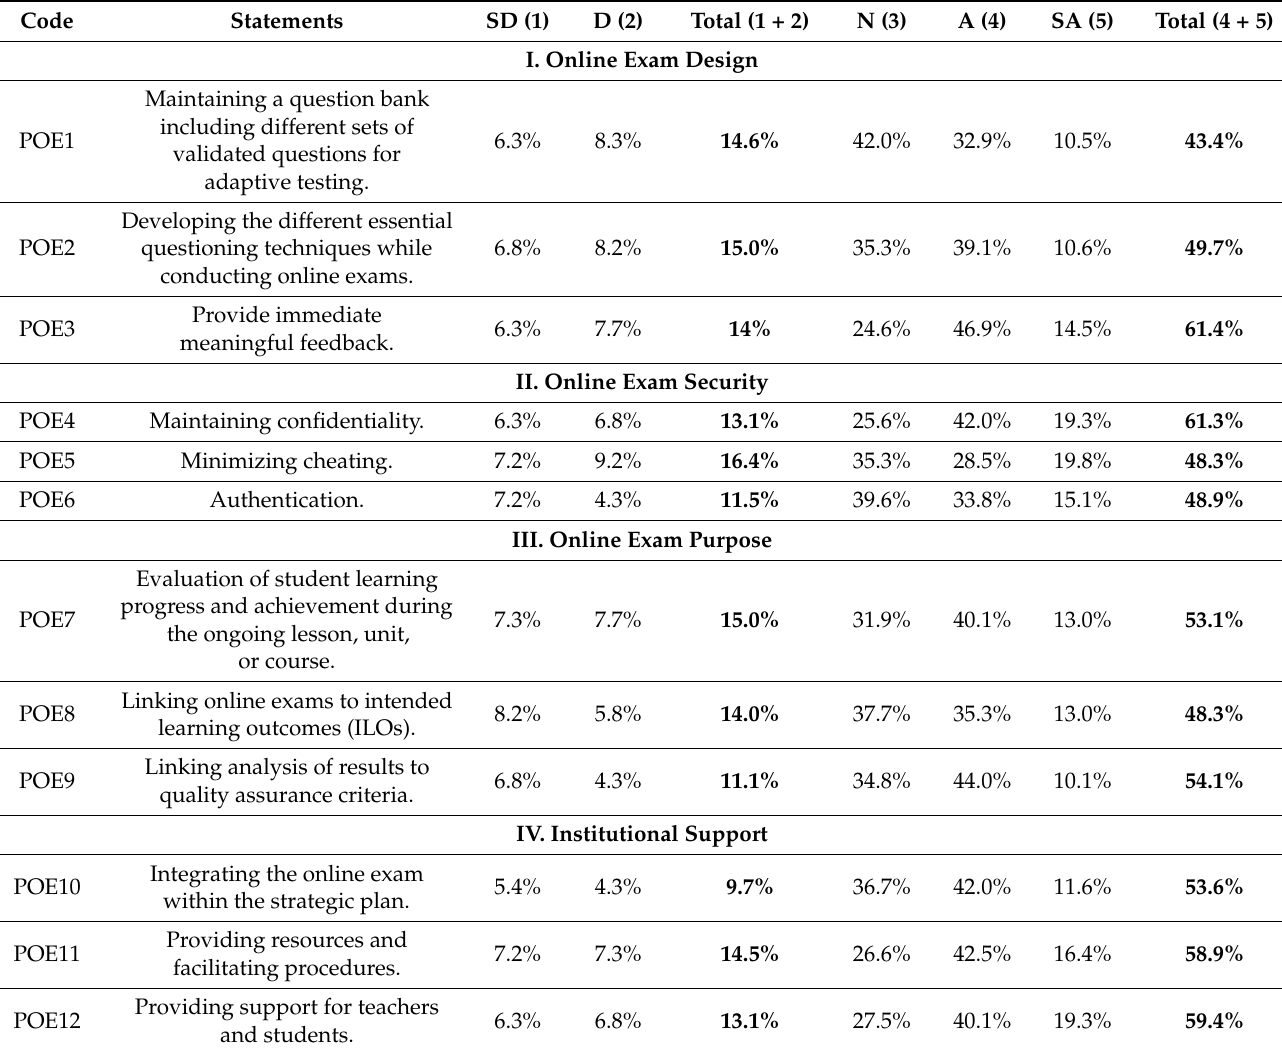
Table 7. Considerations for the Effective Implementation of